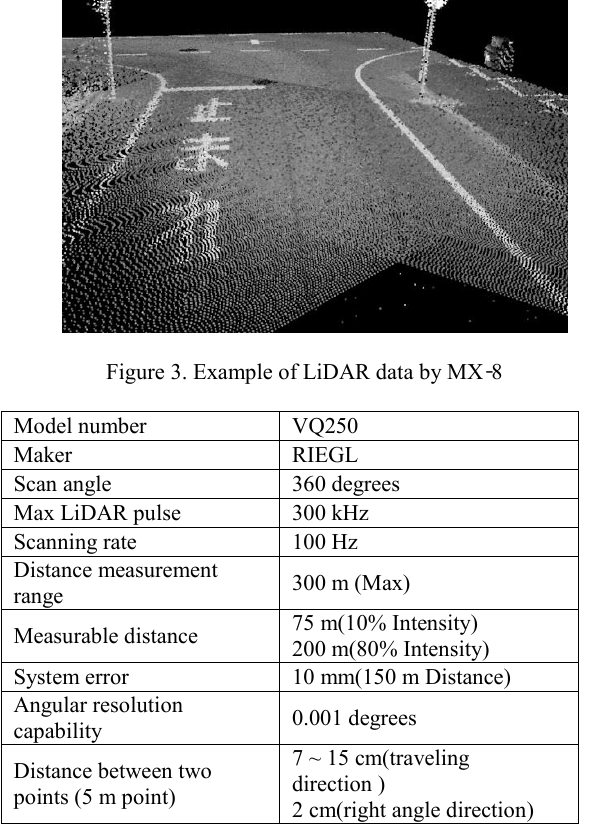
Table 1. Specification of the LiDAR scanner